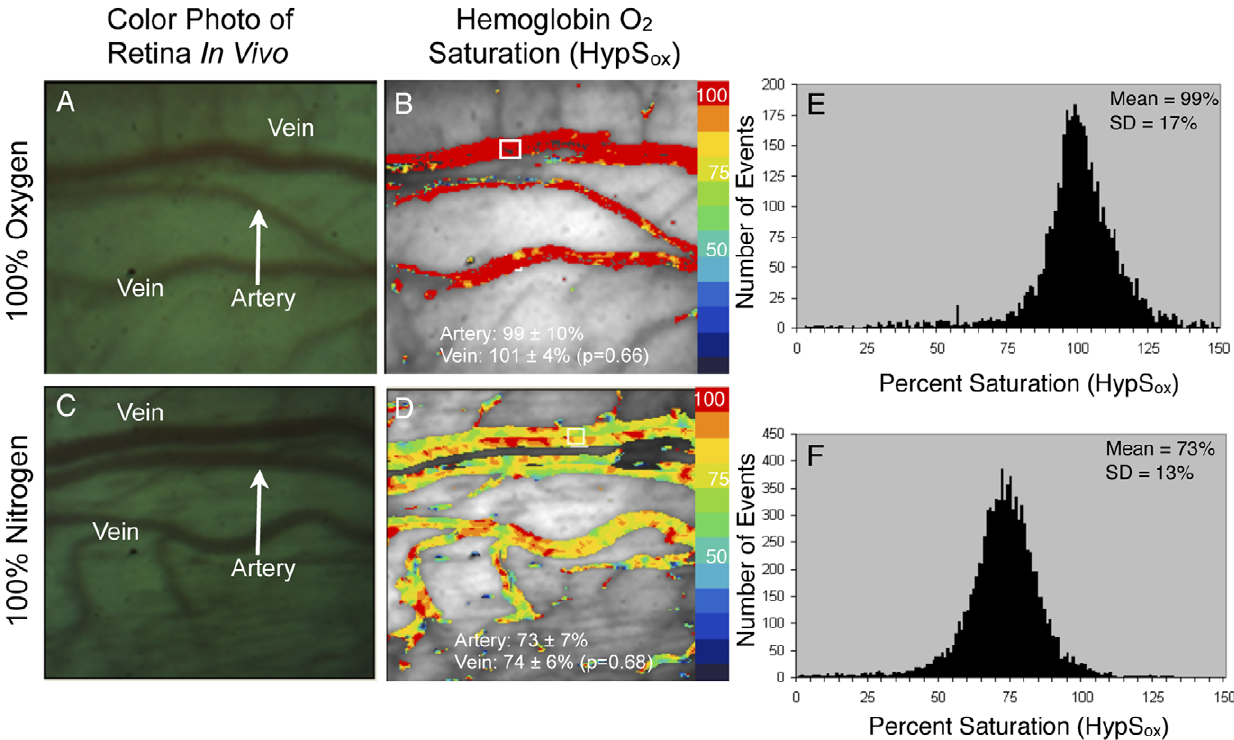
Figure 2. Hemoglobin oxygen saturation (HypS ox ) in rabbit retinal vessels during artificial ventilation with oxygen and nitrogen. (A) Color image of retinal vessels while rabbit is ventilated with 100% oxygen and (C) same rabbit ventilated with 100% nitrogen. Images are approximately of the same area. (B,D) Pseudocolored maps of HypS ox . (B) HypS ox was uniformly high for all vessels after ventilation with 100% oxygen (Mean artery=99 6 10%, Mean vein=101 6 4%; two-tailed, paired, Student T-test, p=0.66, n=10). (D) HypS ox gradually decreased in all vessels during ventilation with 100% nitrogen gas (Mean artery=73 6 7%, Mean vein=74 6 6%; two-tailed, paired, Student T-test, p=0.68, n=10). Arterial and venous HypS ox was calculated by taking the average of 10 non-overlapping measurements along the artery and vein (small white box in panel B illustrates one such measurement area). (E,F) Histograms illustrating the approximately Gaussian distribution of HypS ox measurements for all pixels in panel 2D and 2B. Since arterial saturation cannot be greater than 100% based on blood gas measurements, all pixels with saturation values greater than 100% were scaled to red in the corresponding images. The Student T-test was used to compare the HypS ox of the artery and vein. Color bar represents the percent saturation of hemoglobin with red=100% and blue=0%.